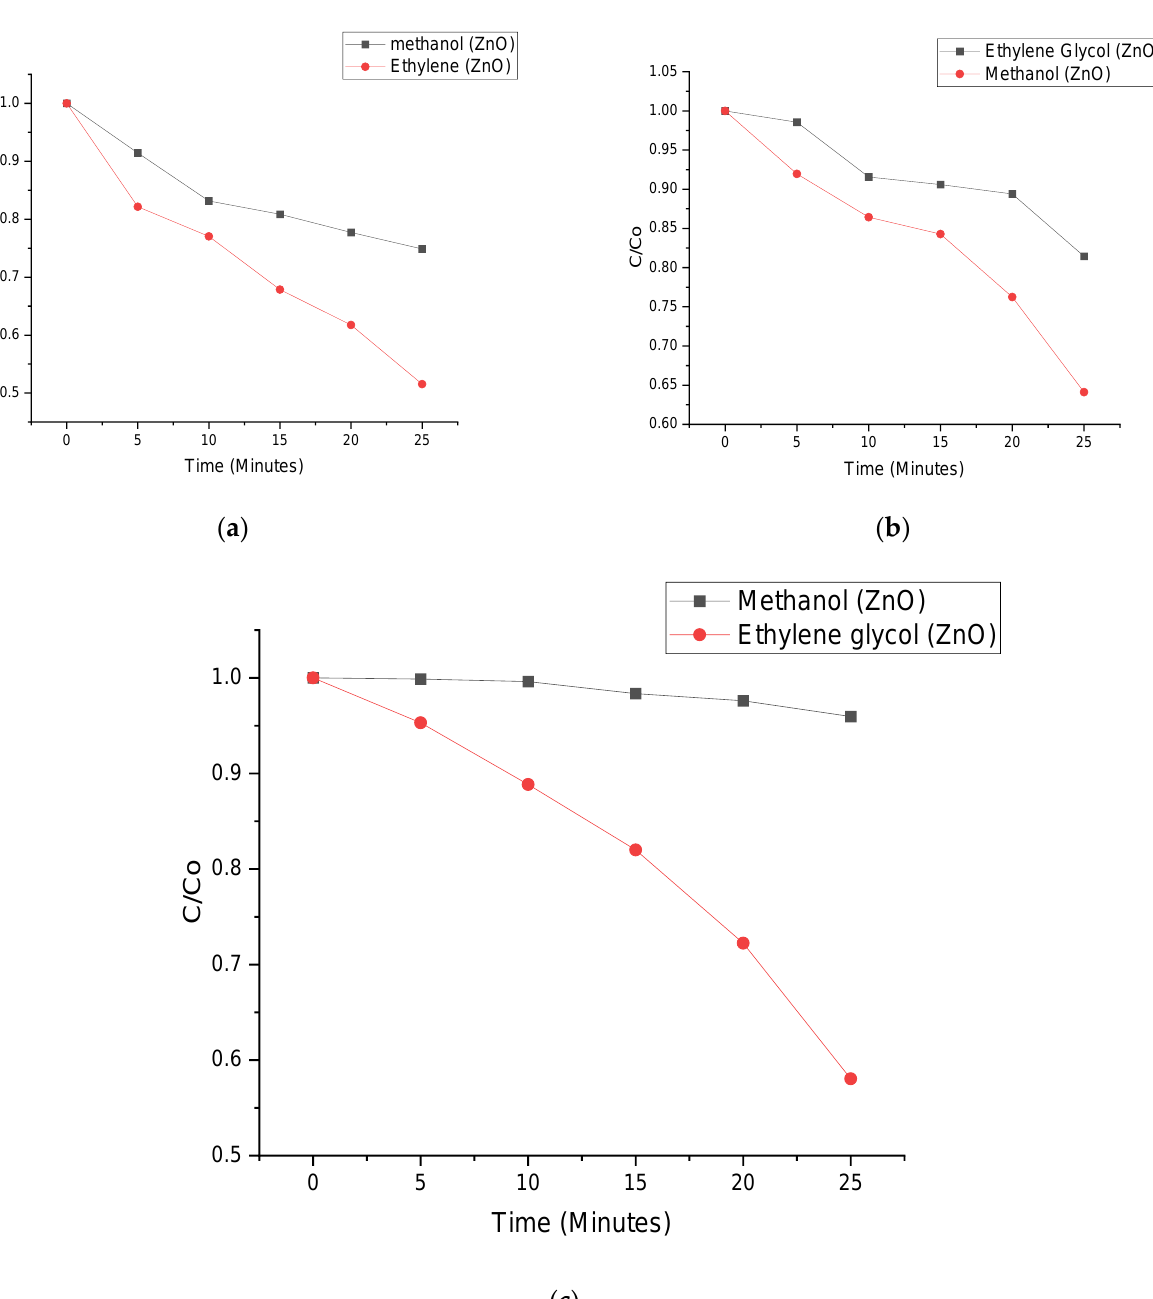
Figure 8. Photo degradation of ( a ) nitenpyram; ( b ) Tetracycline; and ( c ) sulfamethoxazole by methanol (ZnO) belonging to ZnO and ethylene glycol (ZnO) also belongs to ZnO defect.